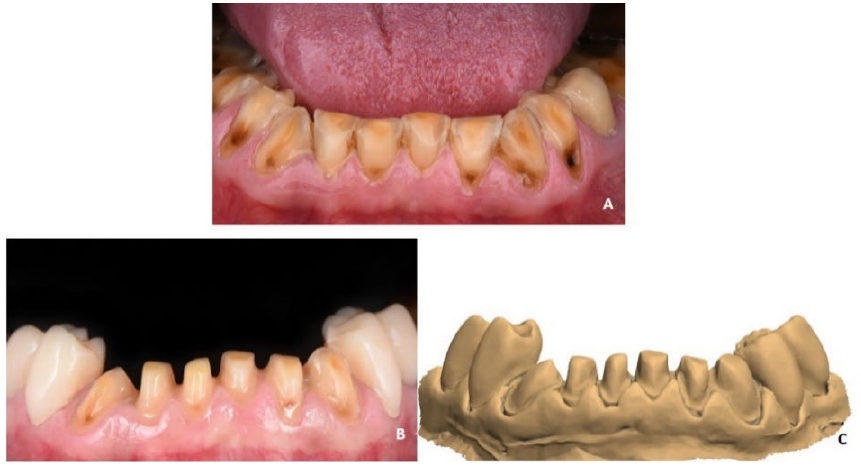
Figure 1. ( A ) initial situation with severe wear; ( B ) preparation of six frontal teeth with chamfer in the vestibular and proximal areas; ( C ) digital impression obtained with intraoral scanner (IOS). Table 1. Printing parameters for lithography-based ceramic manufacturing on a CeraFab System S65 Medical for lithium disilicate anterior teeth